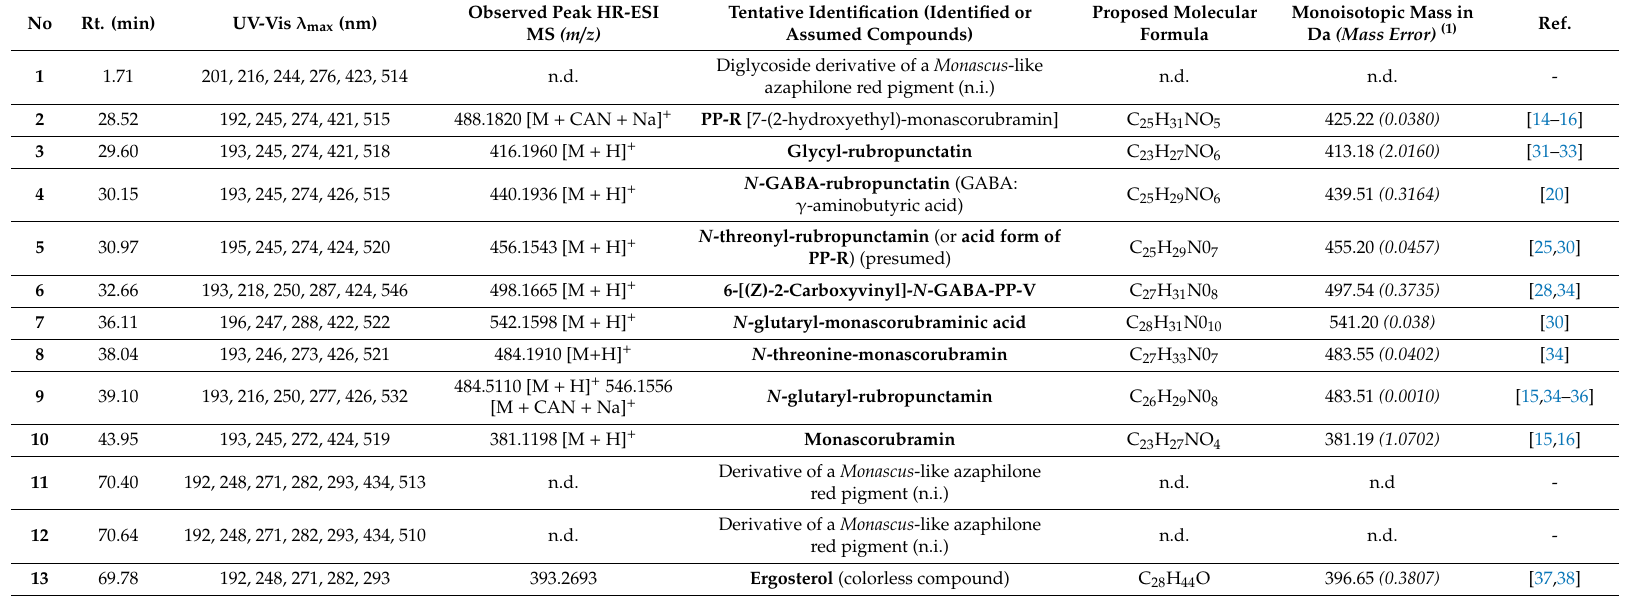
Table 1. Overall compounds (12 derivatives of nitrogen-containing azaphilone red pigments and ergosterol 13 ) identified from the fungal extracts of the marine-derived Talaromyces sp. 30570 fungal strain cultivated in Potato Dextrose Broth (PDB), with reference to the chromatograms shown in Figure 3. Observed Peak HR-ESI Tentative Identification (Identified or Proposed Molecular Monoisotopic Mass in Rt. (min) UV-Vis λ max (nm) MS (m / z) Assumed Compounds) Formula Da (Mass Error) (1)